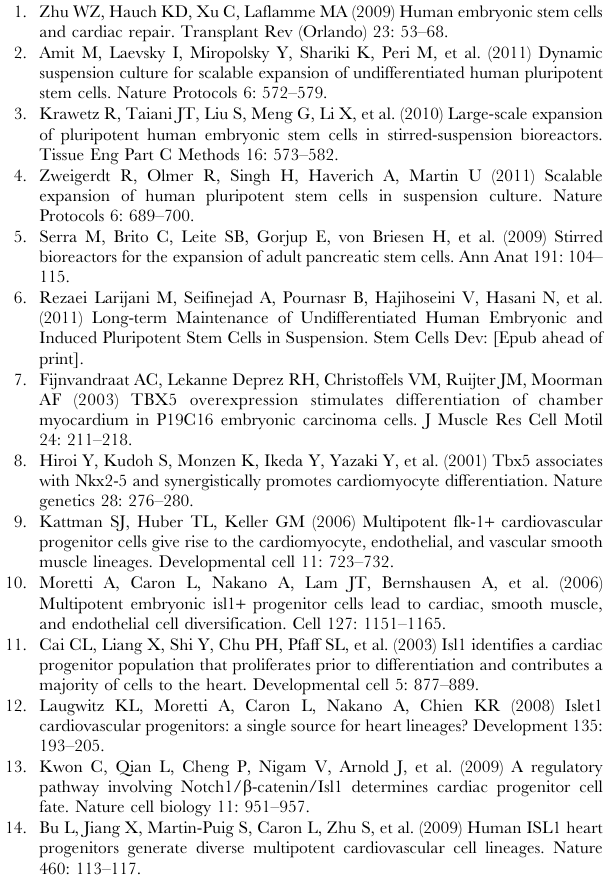
Figure S1 Adherent differentiation and gene expression of hESCs (Royan H5) by the Laflamme et al. protocol